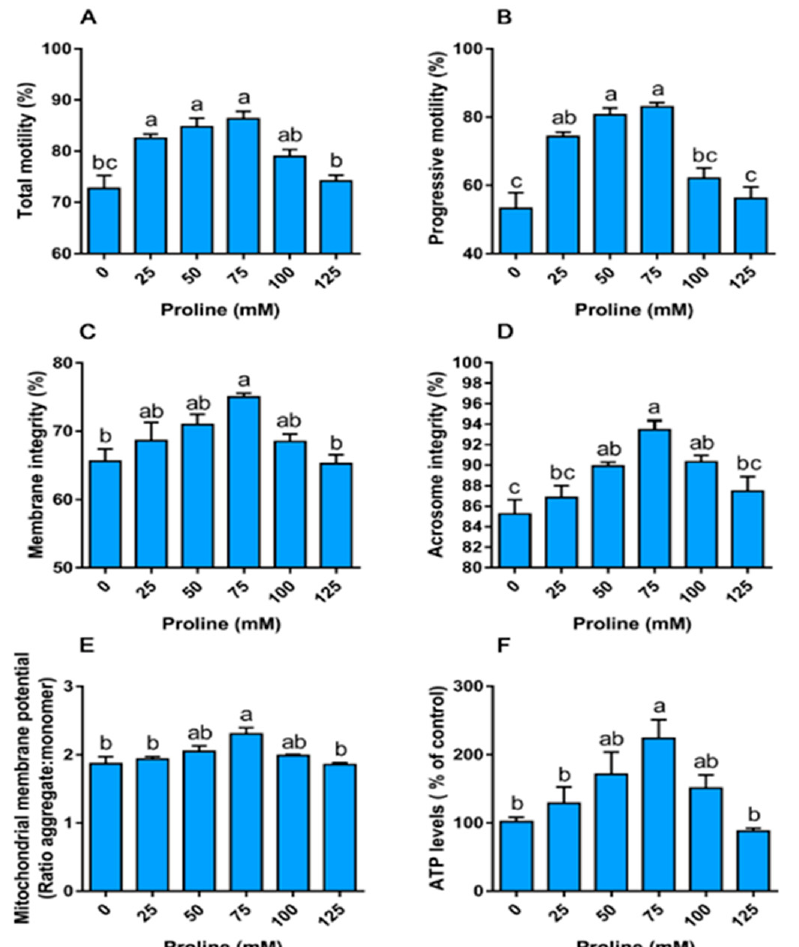
Figure 1. Effect of proline on the motility ( A , B ), integrity ( C , D ), and function ( E , F ) of boar sperm during liquid storage at 17 °C. Samples were supplemented with different concentrations of proline just after ejaculation and detected at day 5 of storage. ( A ) Total motility. ( B ) Progressive motility. ( C ) Membrane integrity. ( D ) Acrosome integrity. ( E ) Mitochondrial membrane potential, results are expressed as the ratio of JC-1 aggregate: monomer. ( F ) ATP levels. Values are shown as mean ± SEM of three independent experiments. Columns with nonidentical superscripts are significantly ( p < 0.05) different from each other in statistics.